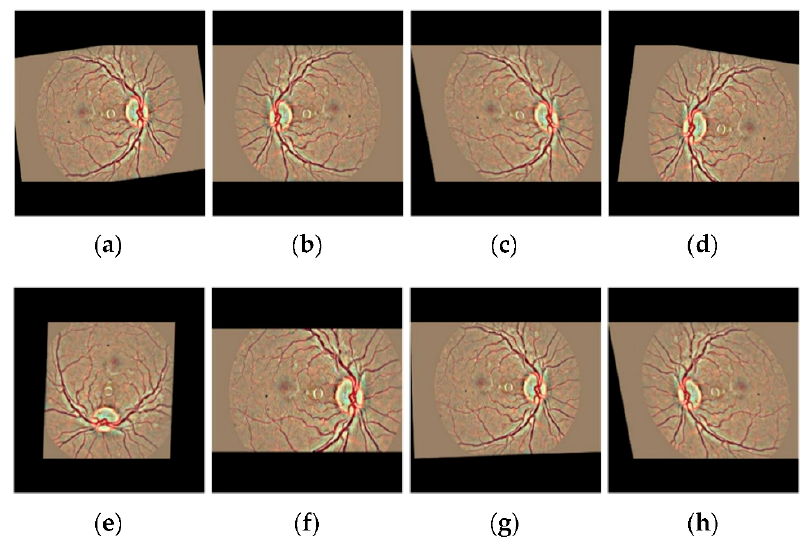
Figure 6. The visual exemplification of some augmentation operations performed on preprocessed images to augment the retinal dataset ( a ) Original image ( b ) Cropping ( c ) Shearing ( d ) Flipping ( e ) Rotating ( f ) Zooming ( g ) Translating ( h ) All augmentation. Table 2. The dataset statistics by using data augmentation